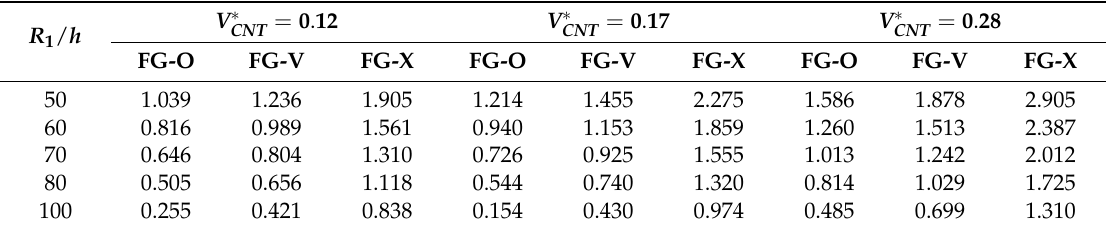
Table 2. Influences of CNT volume fraction, various types of FG-CNTRC and ratio R 1 / h on the non-dimensional frequency of the FG-CNTRC truncated conical shells.